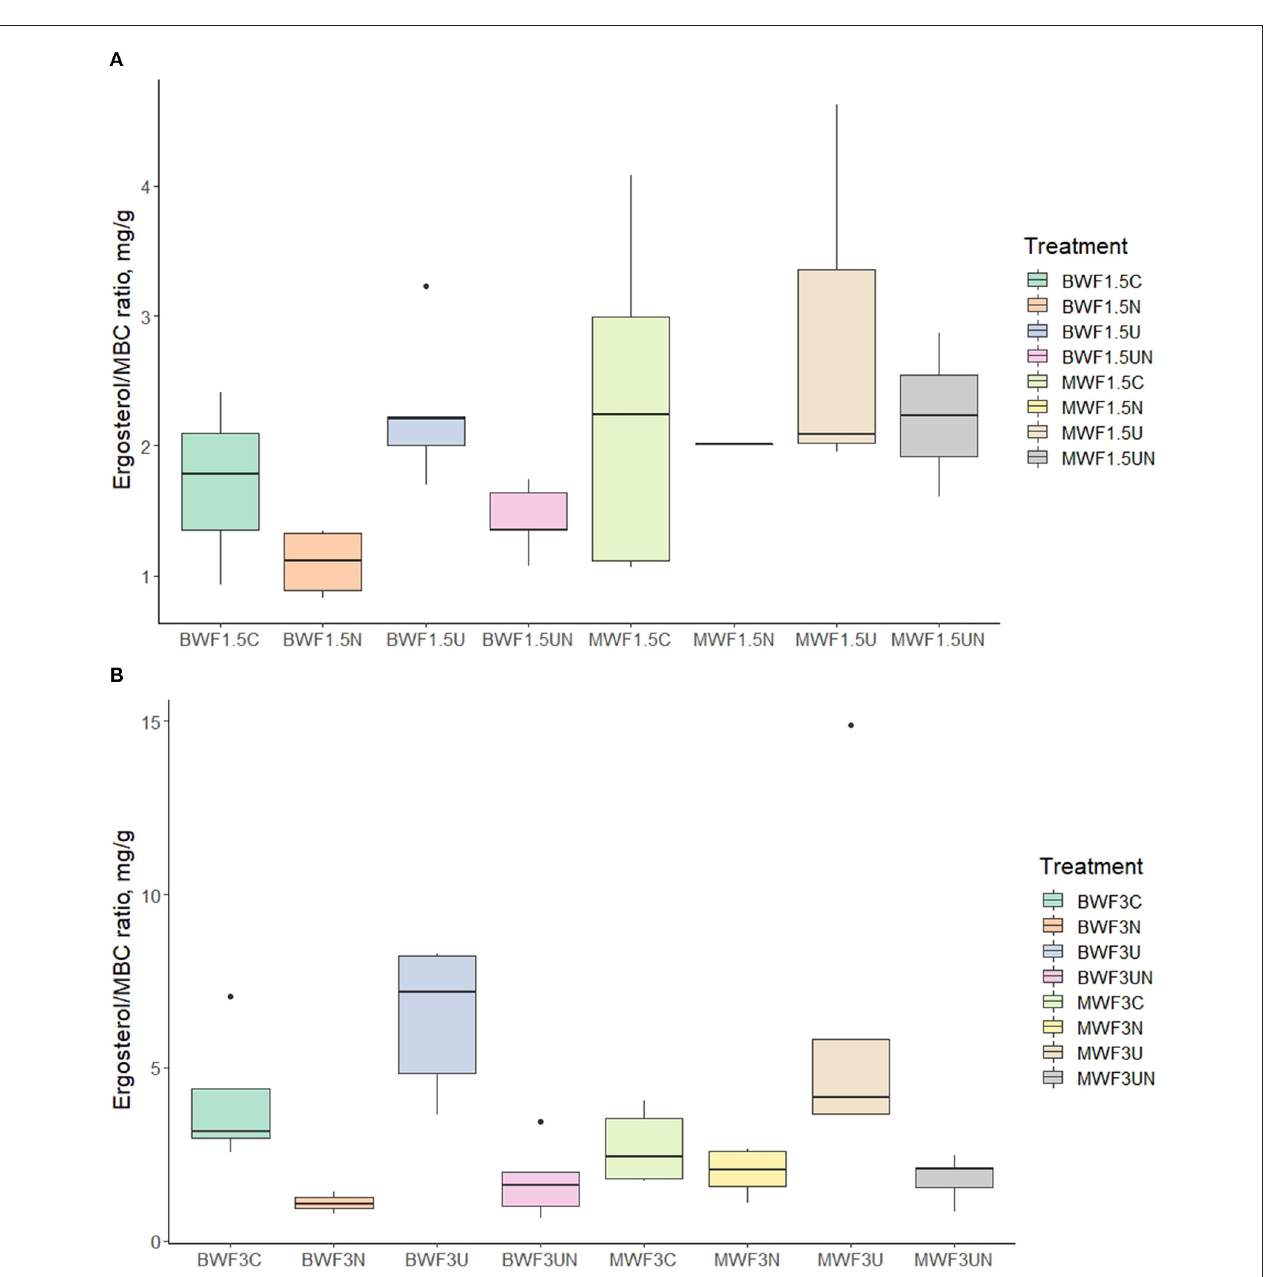
FIGURE 4 | Ergosterol/microbial biomass carbon ratio (mg/g) following (A) 1.5% frass addition with plants and (B) 3.0% frass addition without plants (mean ± 95% confidence interval). Pots were amended with frass alone, or concurrently with nitrification inhibitor (NI), urease inhibitor (UI), or